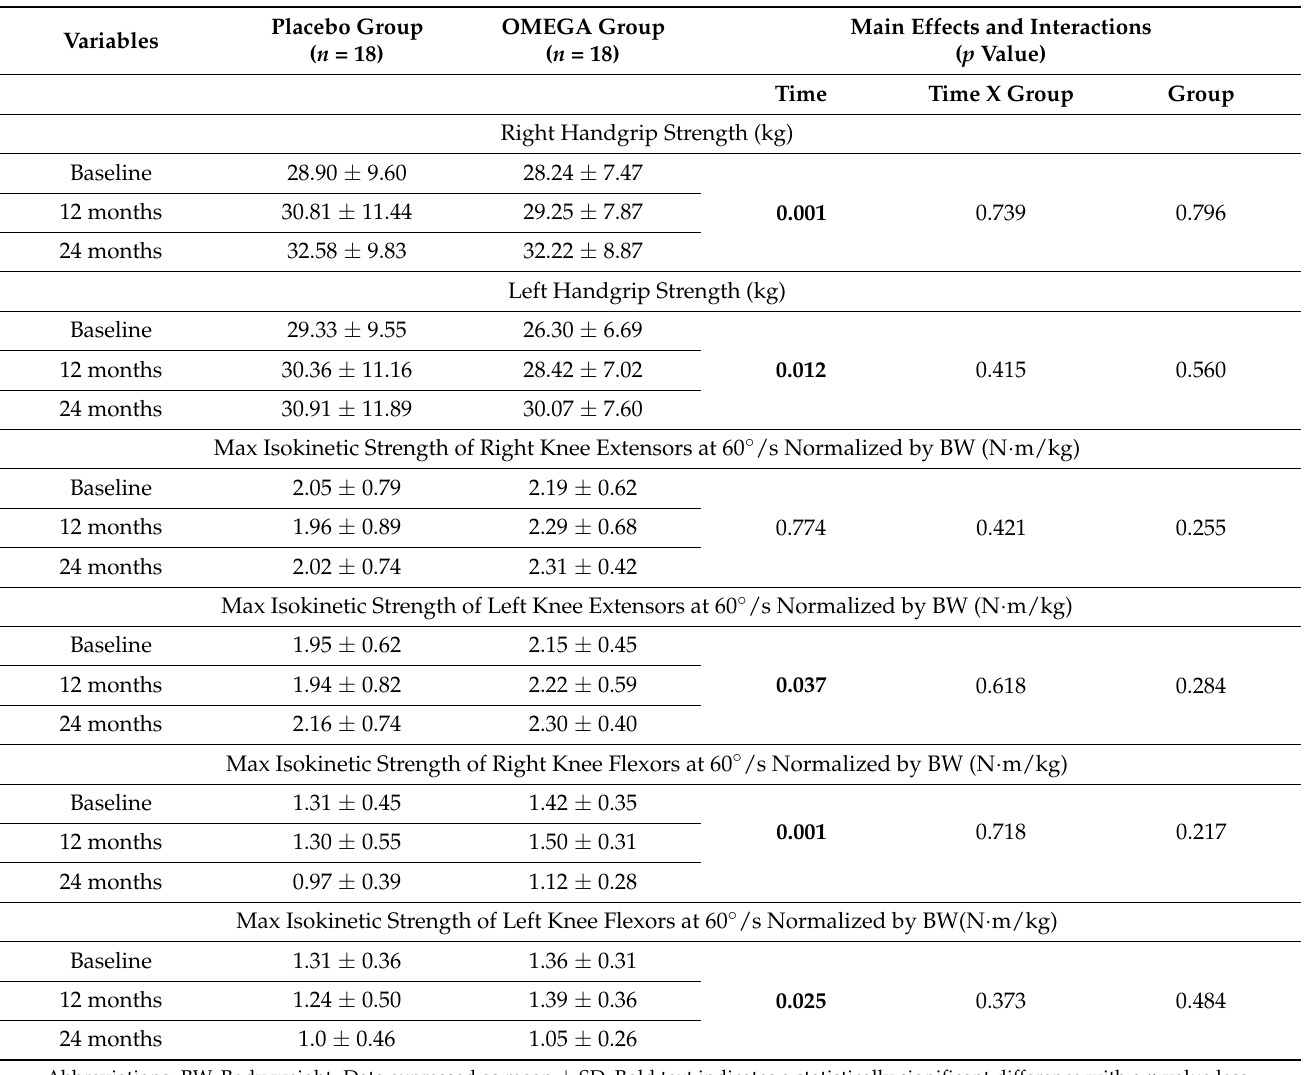
Table 6. Isometric handgrip strength and unilateral leg strength in both groups for all three time-points excluding the dropouts.